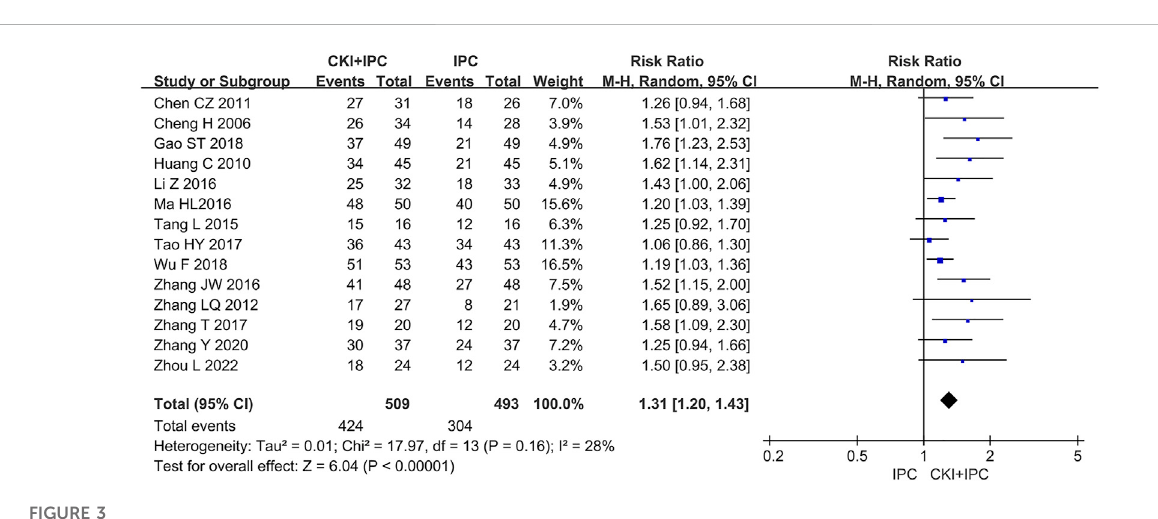
FIGURE 3 Forestplotandpooledriskratiosfortheassociationofobjectiveresponserate(ORR)withCKI +IPCandIPC.CKI,CompoundKushenInjection;IPC, intraperitoneal